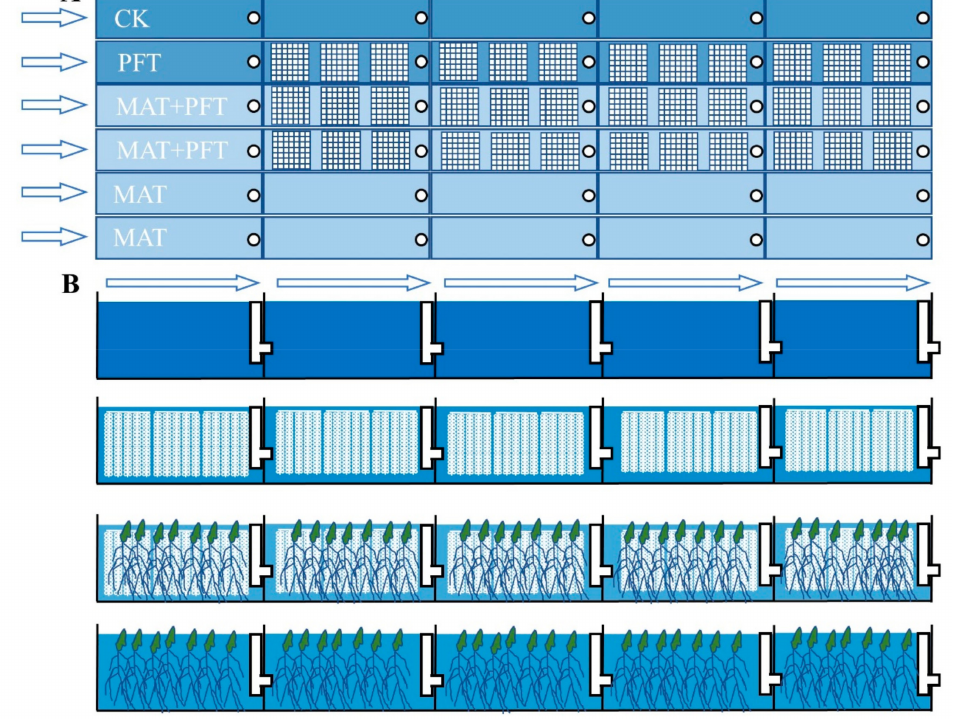
Figure 2. Schematic diagrams of the pilot-scale surface flow constructed wetlands (PSCW). Planform ( A ) and lateral views ( B ) of the PSCW are demonstrated, and the arrow points in the flow direction in the PSCWs. The treatments shown in ( A ), as control (CK), polyethylene fiber treatment (PFT), M . aquaticum and polyethylene fiber treatment (MAT+PFT), and M . aquaticum treatment (MAT), respectively, from top to bottom, are also shown in ( B ). Water-level connecting pipes controlling the water flow in the PSCW are demonstrated in each treatment